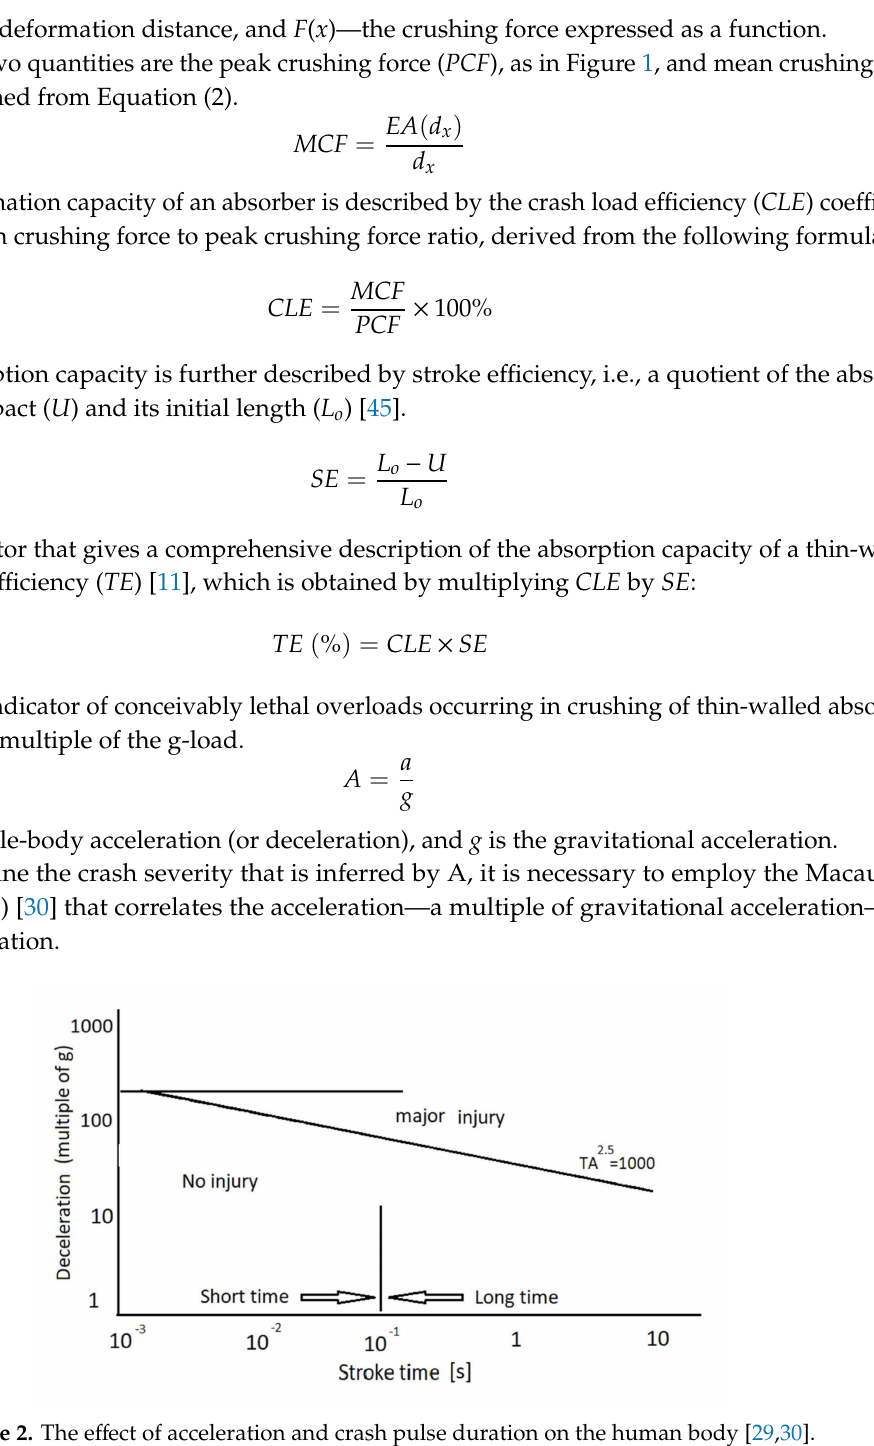
Figure 2. The e ff ect of acceleration and crash pulse duration on the human body